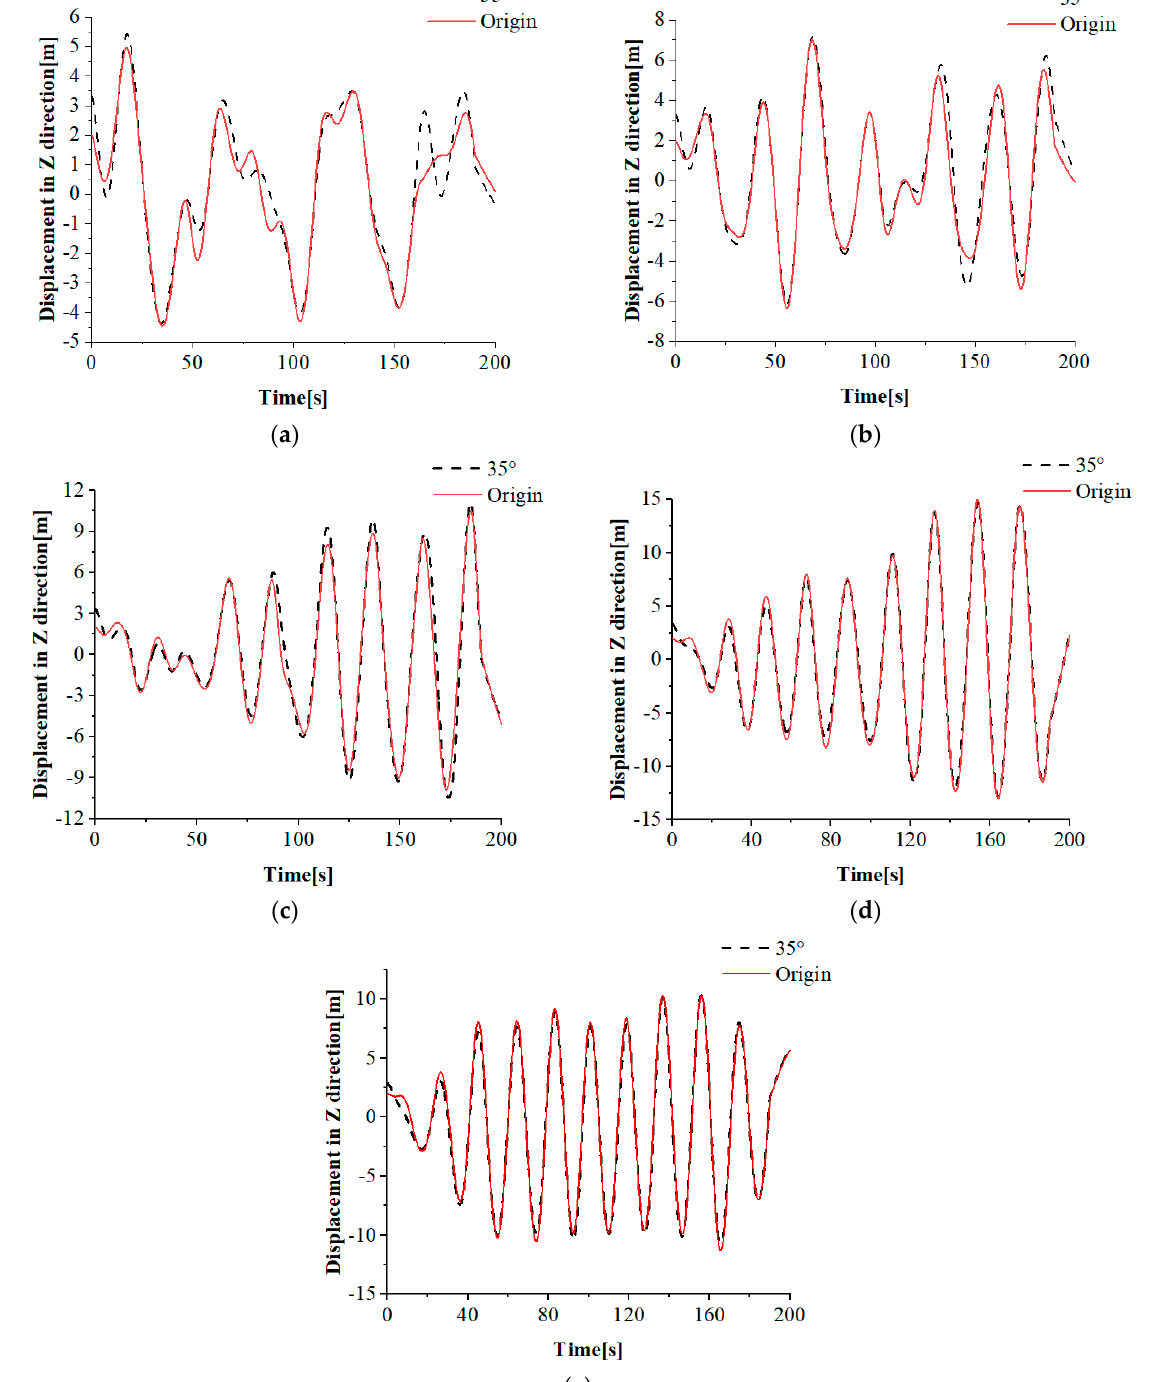
Figure 33. Z direction displacement of the pedestal under different wave periods. ( a ) T = 38.73 s; ( b ) T = 30.98 s; ( c ) T = 25.82 s; ( d ) T = 22.13 s; ( e ) T = 19.36 s.